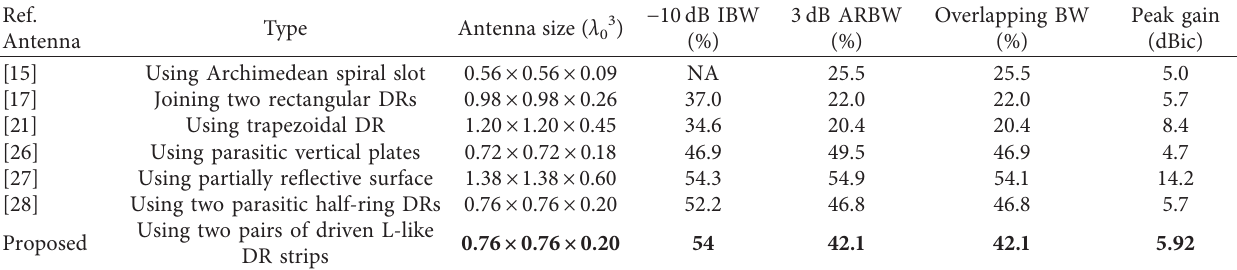
Table 2: Comparison of the designed antenna with previously reported antennas Ref.